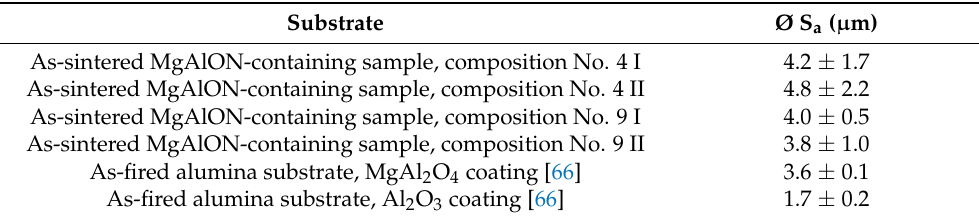
Table 7. Measured mean surface roughness parameters S a for MgAlON- and Al 2 O 3 -/MgAl 2 O 4 - containing [66] substrates.